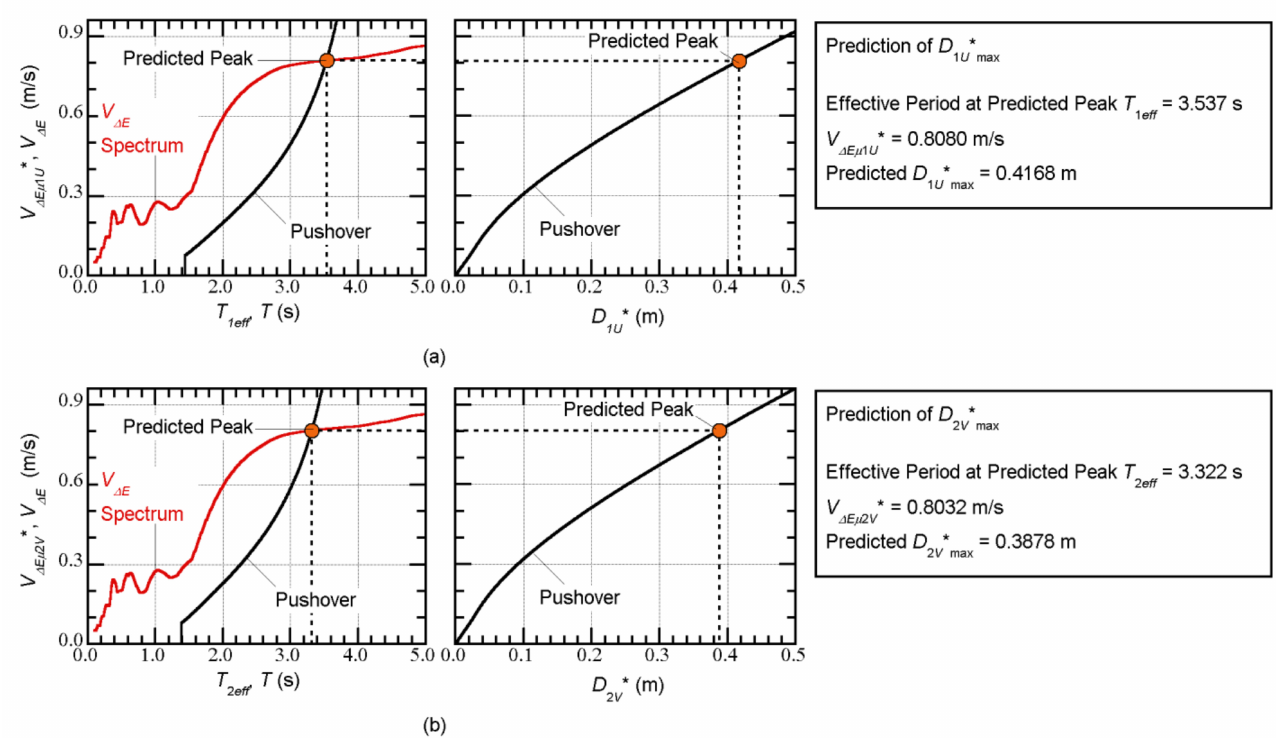
Figure 19. Prediction of the peak equivalent displacements (model: Model-Tf44, ground motion: TCU): ( a ) Prediction of the peak of the first modal response and ( b ) prediction of the peak of the second modal